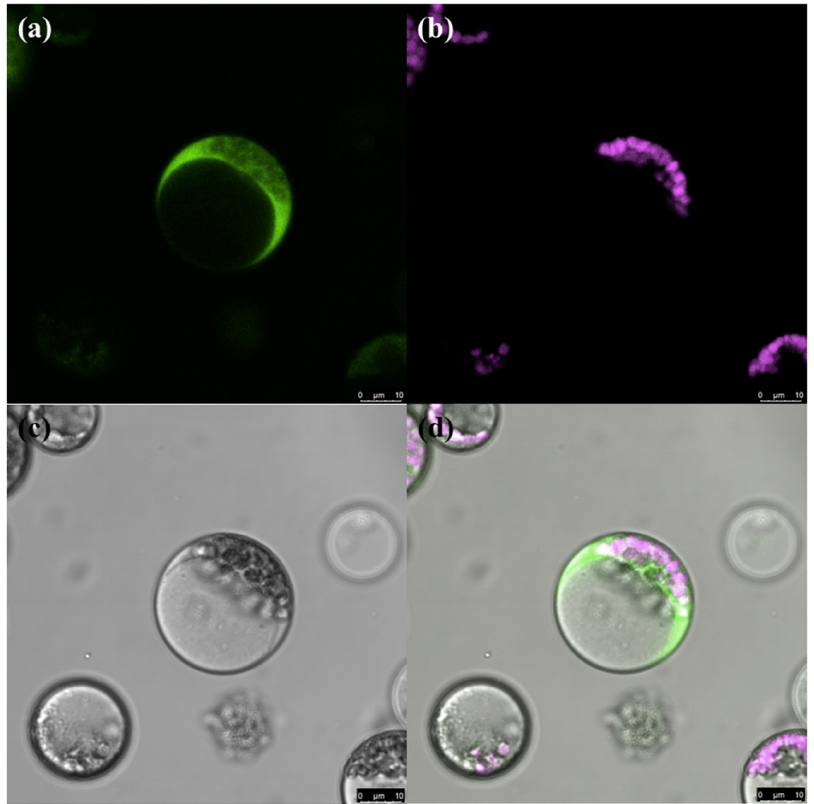
Figure 3. Subcellular localization of YFP-aequorin in maize protoplast. ( a ) YFP-aequorin, ( b ) chloro- phyll, ( c ) bright field, ( d ) merged image.